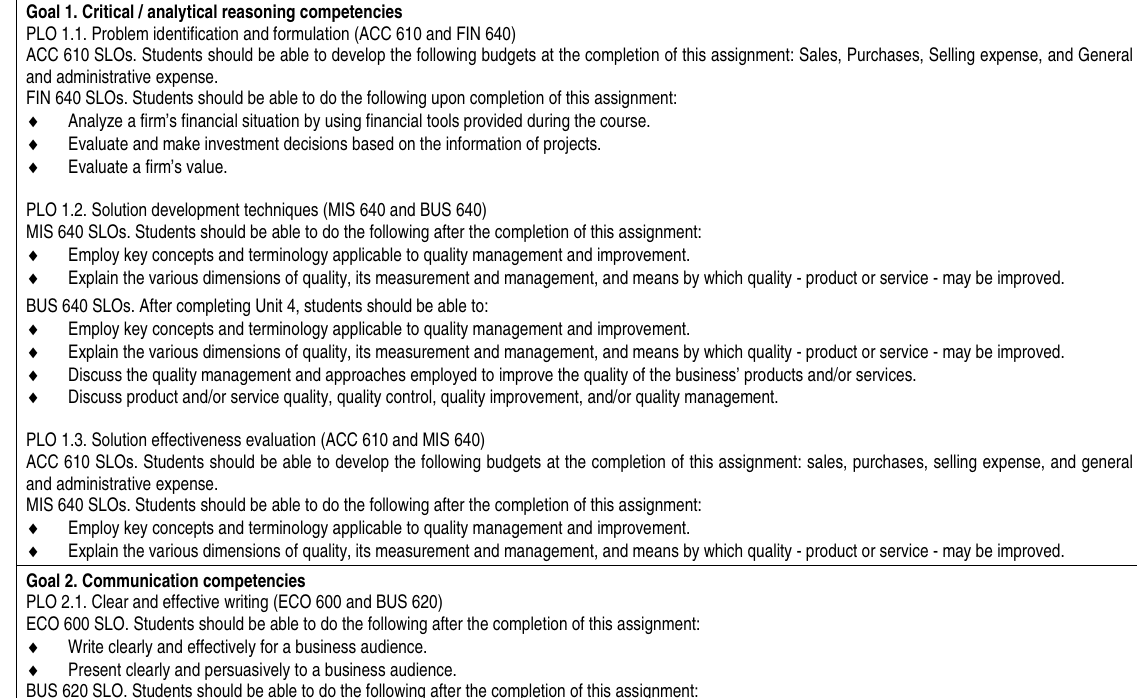
Table 4. The MBA program learning goals, Program Learning Outcomes (PLOs), and their corresponding course-level Student Learning Outcomes